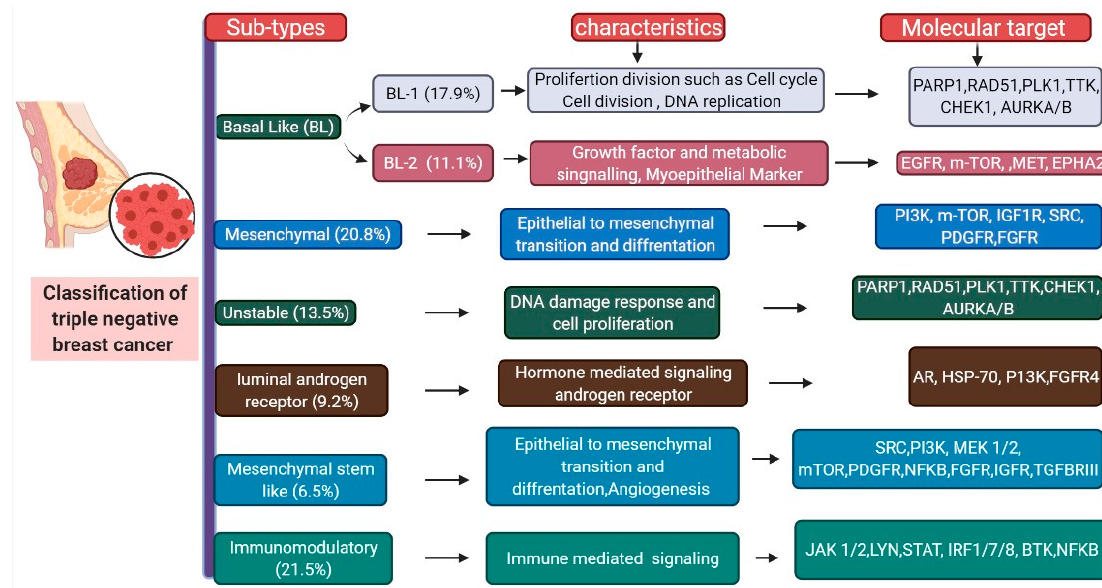
Figure 2. Classification of triple-negative breast cancer.